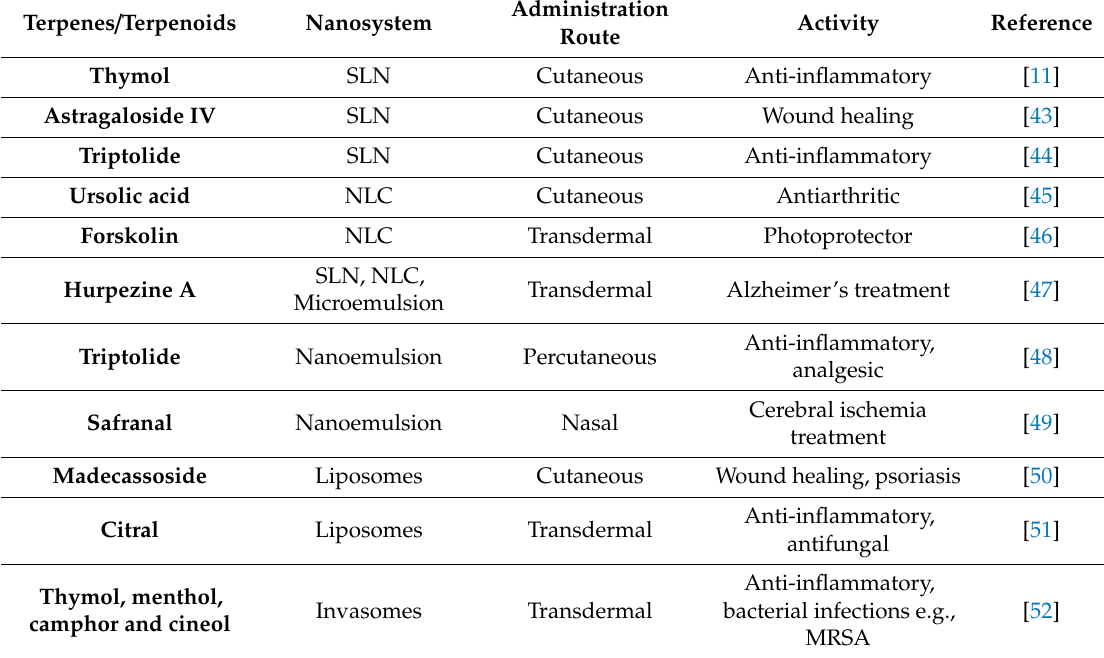
Table 2. Terpenes as bioactive compounds encapsulated in lipid-based nanosystems for anti-inflammatory